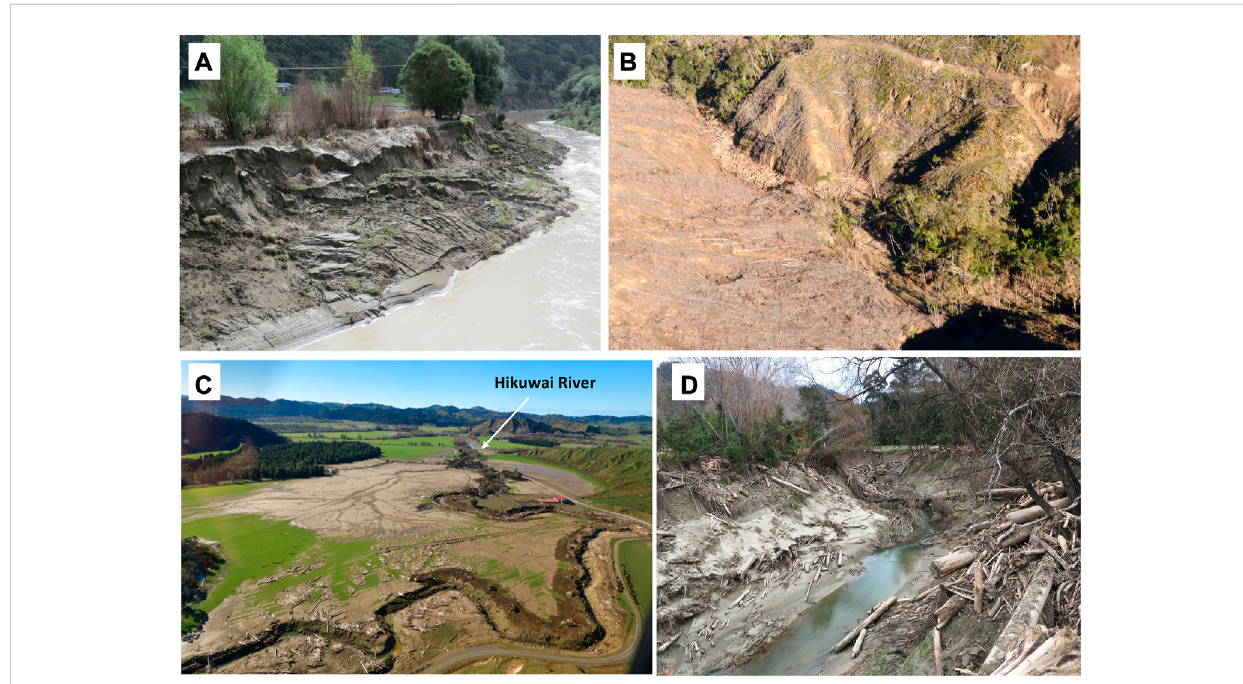
FIGURE 7 Hillslope failures following deforestation and subsequent forest management practices have induced excessive fl ux of fi ne-grained sediment and wastewood throughtheHikuwairiver system. Thesematerialsarereadilyconveyed within aslot-likechannel fromtheMountains totheSea. (A) Hikuwai River and fl oodplain. Photo: 2 February, MM; (B) Wood waste generated from logging activities and delivered to a fi rst-order stream channel by shallow landslides, debris slides and debris fl ows, Tapaue Stream, Hikuwai catchment. Photo: 11 July 2018. Townsend, GNS Science; (C) Overbank sedimentation and wood deposits, Tapaue Stream fl oodplain. Hikuwai River labelled ( fl ow left to right). Photo: 11 July 2018 (D) . Townsend, GNS Science (withpermission); (D) Forestryslash(woodwaste)withinandadjacentto theMangatokerauRiver~300 mupstreamfromitscon fl uencewiththeHikuwai (looking upstream). Note the entrenched, narrow channel inset within a fi ne-grained fl oodplain. Photo: 29 August 2018,